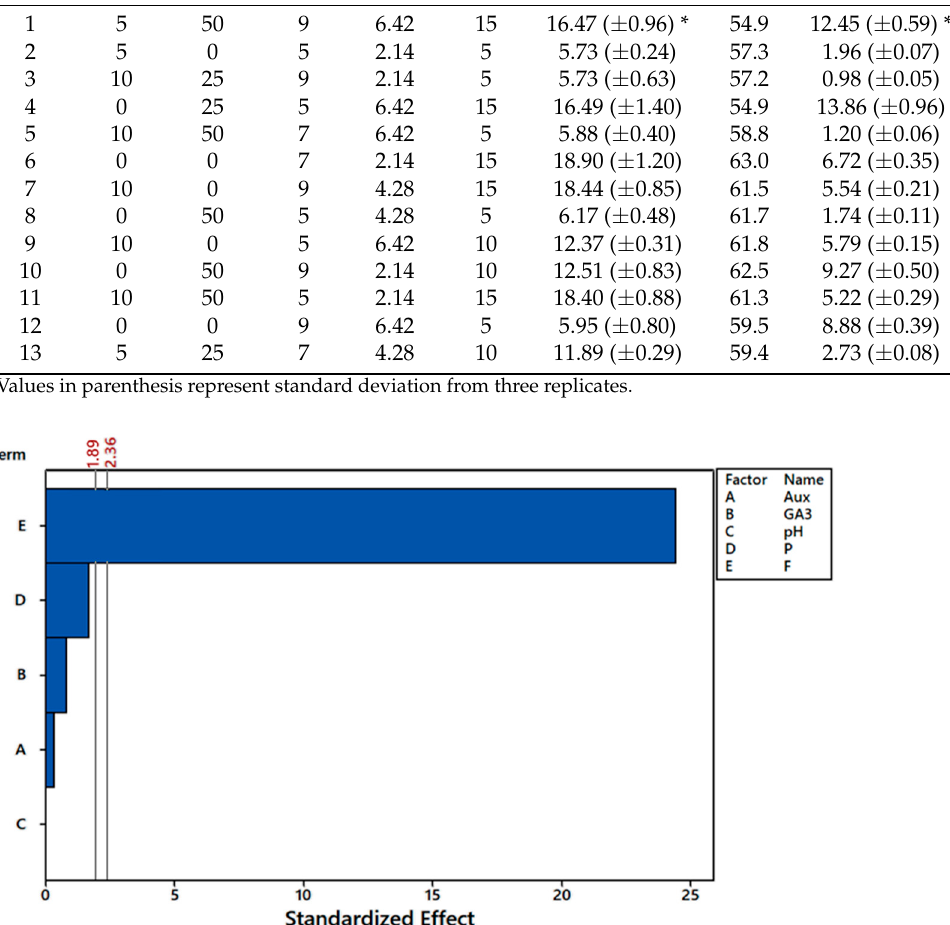
Table 5. Removal of fluoride in mg ( F rem ), percentage ( F rem ( % ) ), and per mass of plant ( F rem / plant , mg g − 1 ) for the definitive screening design experiment. Treat.